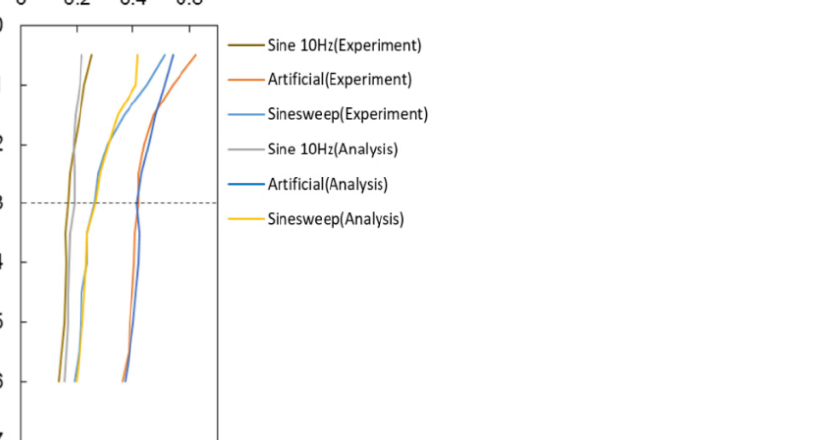
Figure 14. Peak ground acceleration from the bottom to the surface under different input waves by experiment results and numerical analysis results.